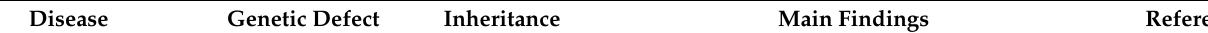
Table 1. Evidence of the role of gut microbiota–host interactions in human inborn errors of